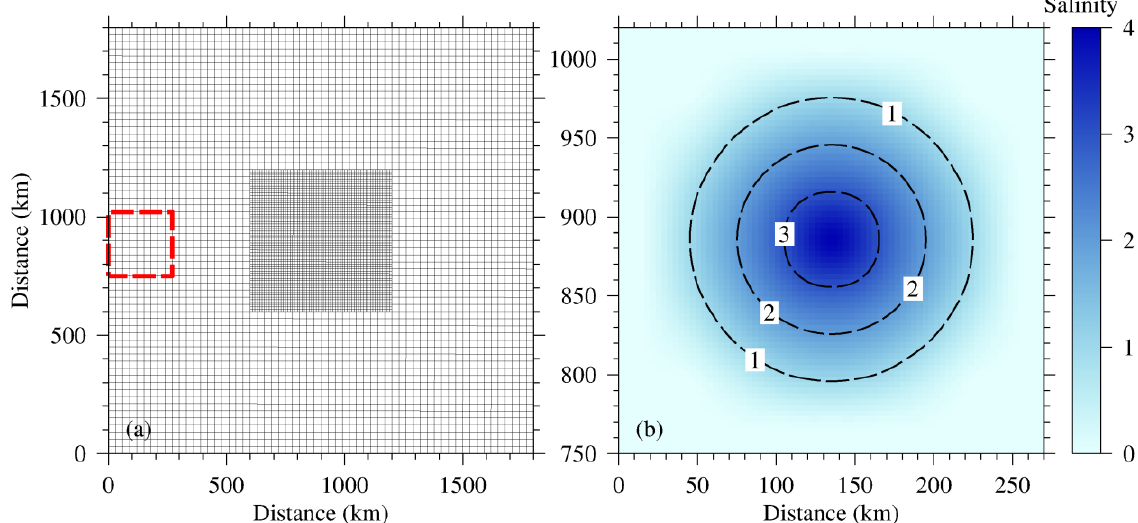
Figure 4. ( a ) numerical domain of the nested grid. ( b ) The initial salinity distribution of the ideal experiment in the area indicated by the red dashed line box in ( a ).